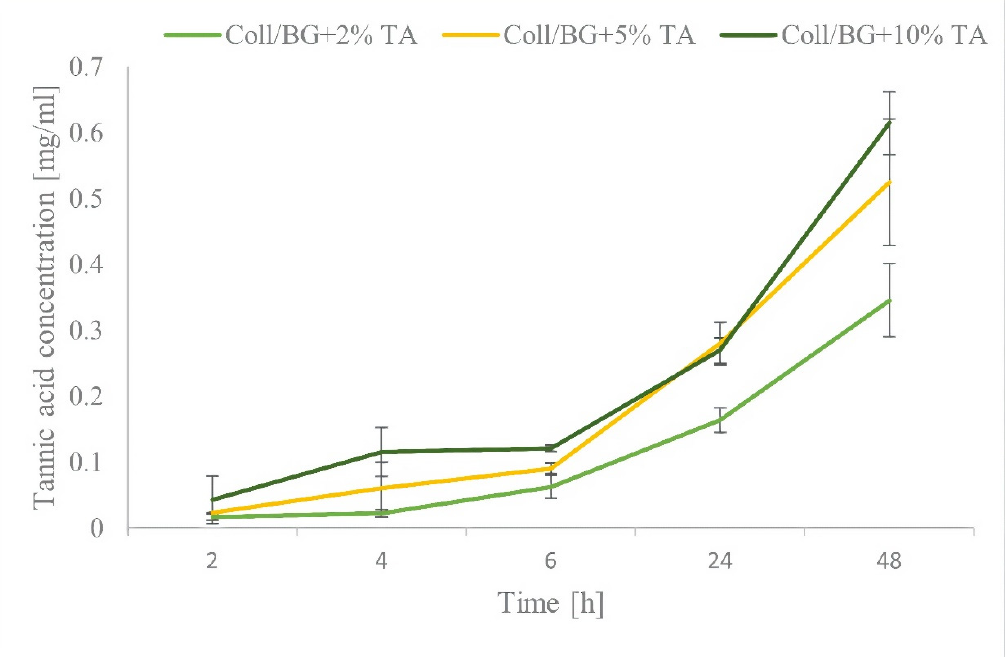
Figure 4. The tannic acid release rate from hydrogels.